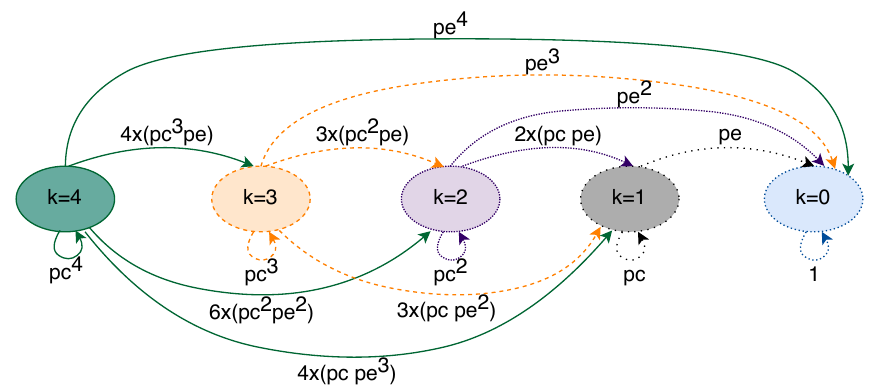
Figure 6. State diagram for the model of a